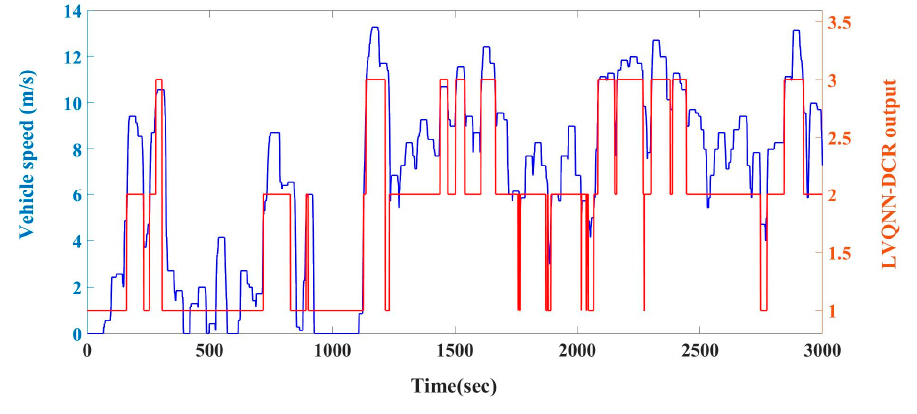
Figure 8. LVQNN_DCR output.